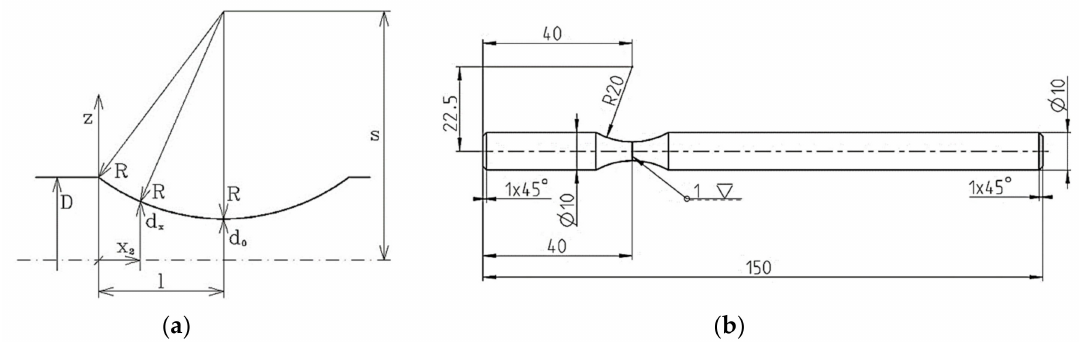
Figure 14. ( a ) The change of the cross-section of the tested specimen with dependence on the centreline x ; ( b ) the resulting optimal shape of the tested specimen of the designed testing